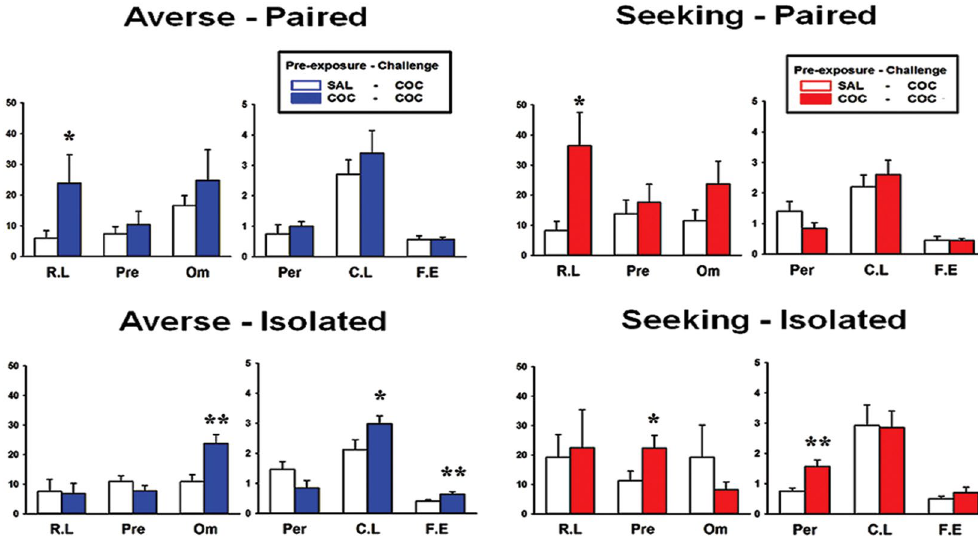
Figure 4. Analysis of behavioral parameters. The list of the choice-related behavioral parameters is as follows: reward latency (R.L), premature response (Pre), omission (Om), perseverative response (Per), correct response latency (C.L), and feed-tray entry (F.E). Each parameter’s units of measurement are as follows: R.L. (sec), Pre (%), Om (%), Per (actual number of touch), C.L. (sec), F.E (the number of feed-tray entries during ITI divided by total number of trials initiated). Data for these parameters obtained on the challenge day were analyzed using the independent sample t-test and compared between the saline and cocaine pre-exposed rats. In the averse- paired and seeking-paired groups, only differences for reward latency were significant between the saline and cocaine pre-exposed sub-groups. In the seeking-isolated group, differences in the premature and